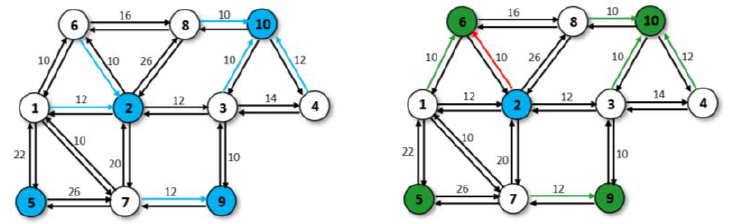
Figure 7. Simple example of system reengineering.